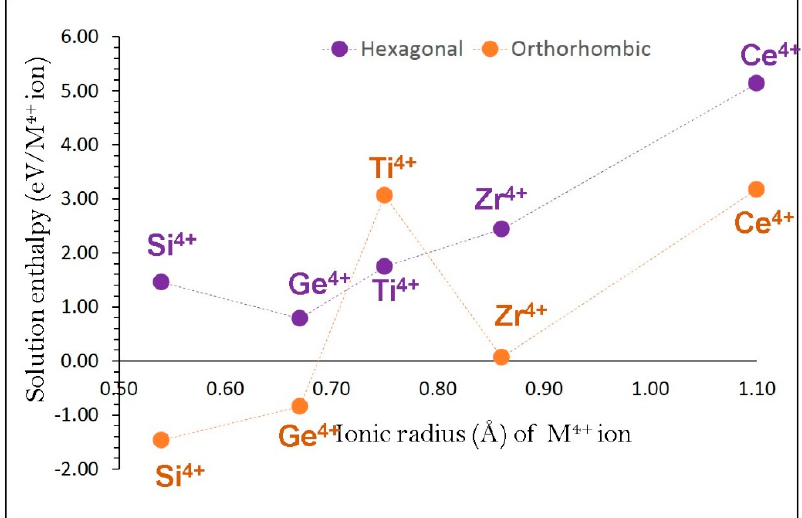
Figure 8. Enthalpy of solution of MO 2 (M = Si, Ge, Ti, Zr and Ce) with respect to the M 4+ ionic radius in NaFeO 2 .